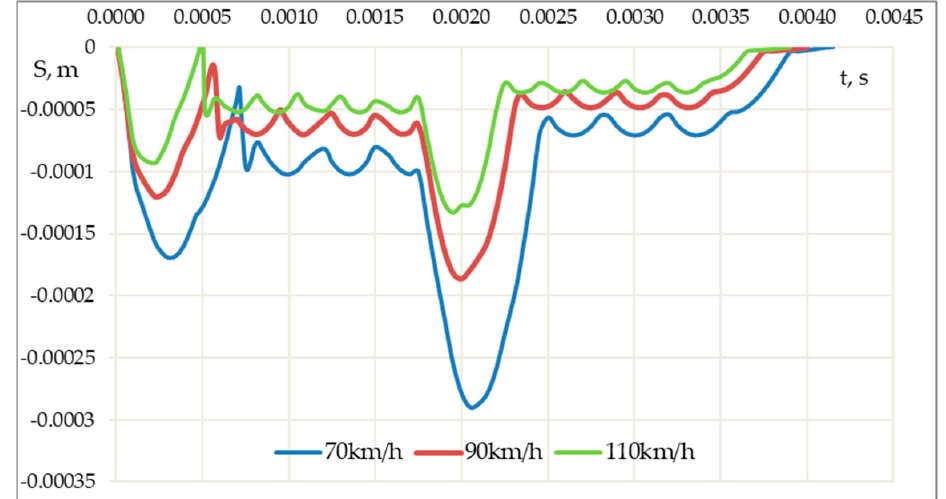
Figure 5. The dependence of oscillation amplitudes of the track structure cross-section over time